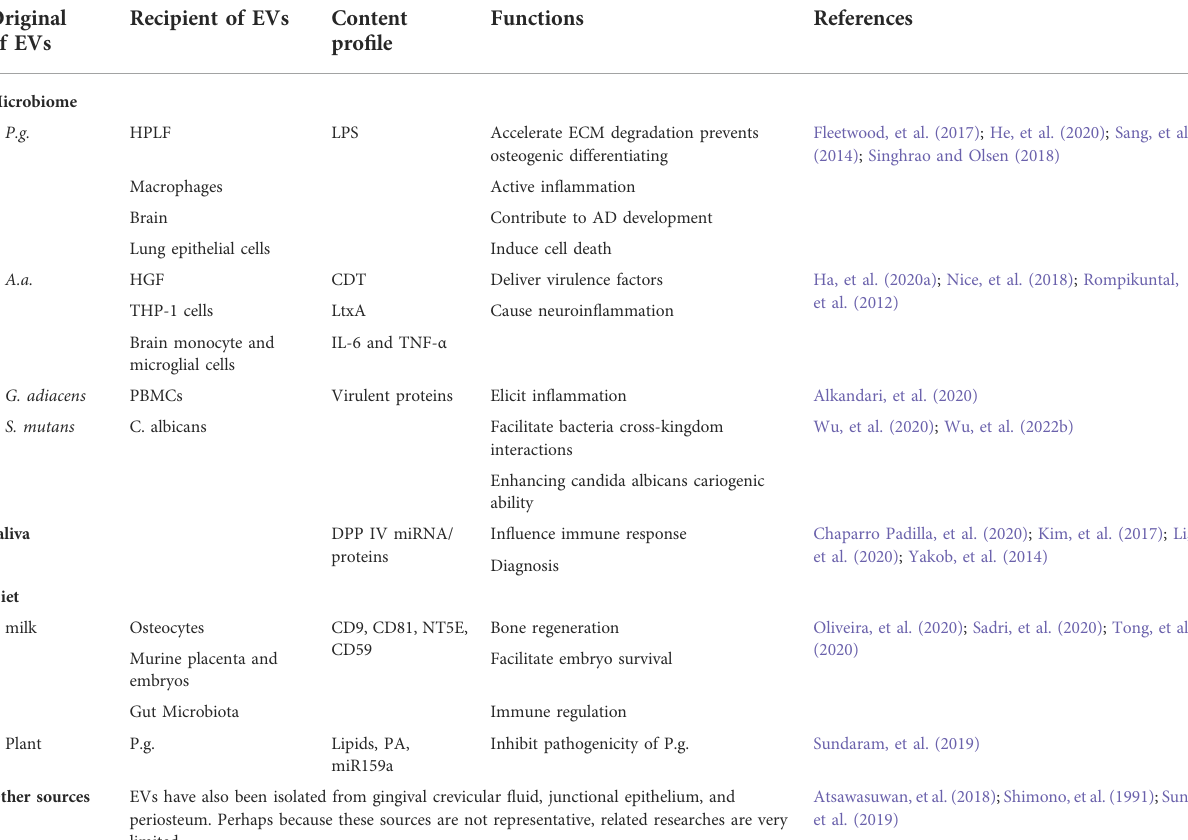
TABLE 2 The cell-independent sources and features of extracellular vesicles